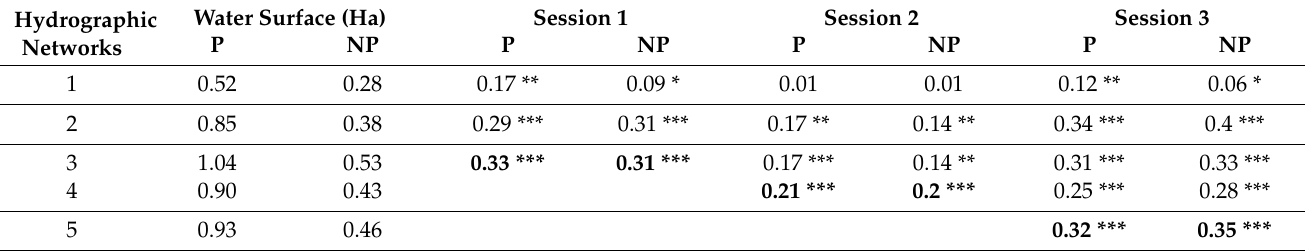
Table 1. Pseudo R 2 of negative binomial regressions between the distances to the nearest water body of each hydrographic network and the aquatic insect abundance. Numbers in bold represent pseudo R 2 between the aquatic insect abundance of a session and the mapping survey carried out during this session. Each hydrographic network declines with ponds (“P”) and without ponds (“NP”). Hydrographic network 1 is the OpenStreetMap stream; network 2 is the completed stream; and networks 3, 4, and 5 are the full networks surveyed on 12 April, 5 May, and 27 May, respectively. Note for p values: *** p < 0.001, ** p < 0.01, * p <